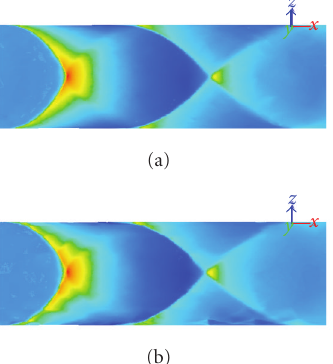
Figure 17: Detail of the solution in proximity of the blade and downstream, viewed from the side—(a) with projection, (b)